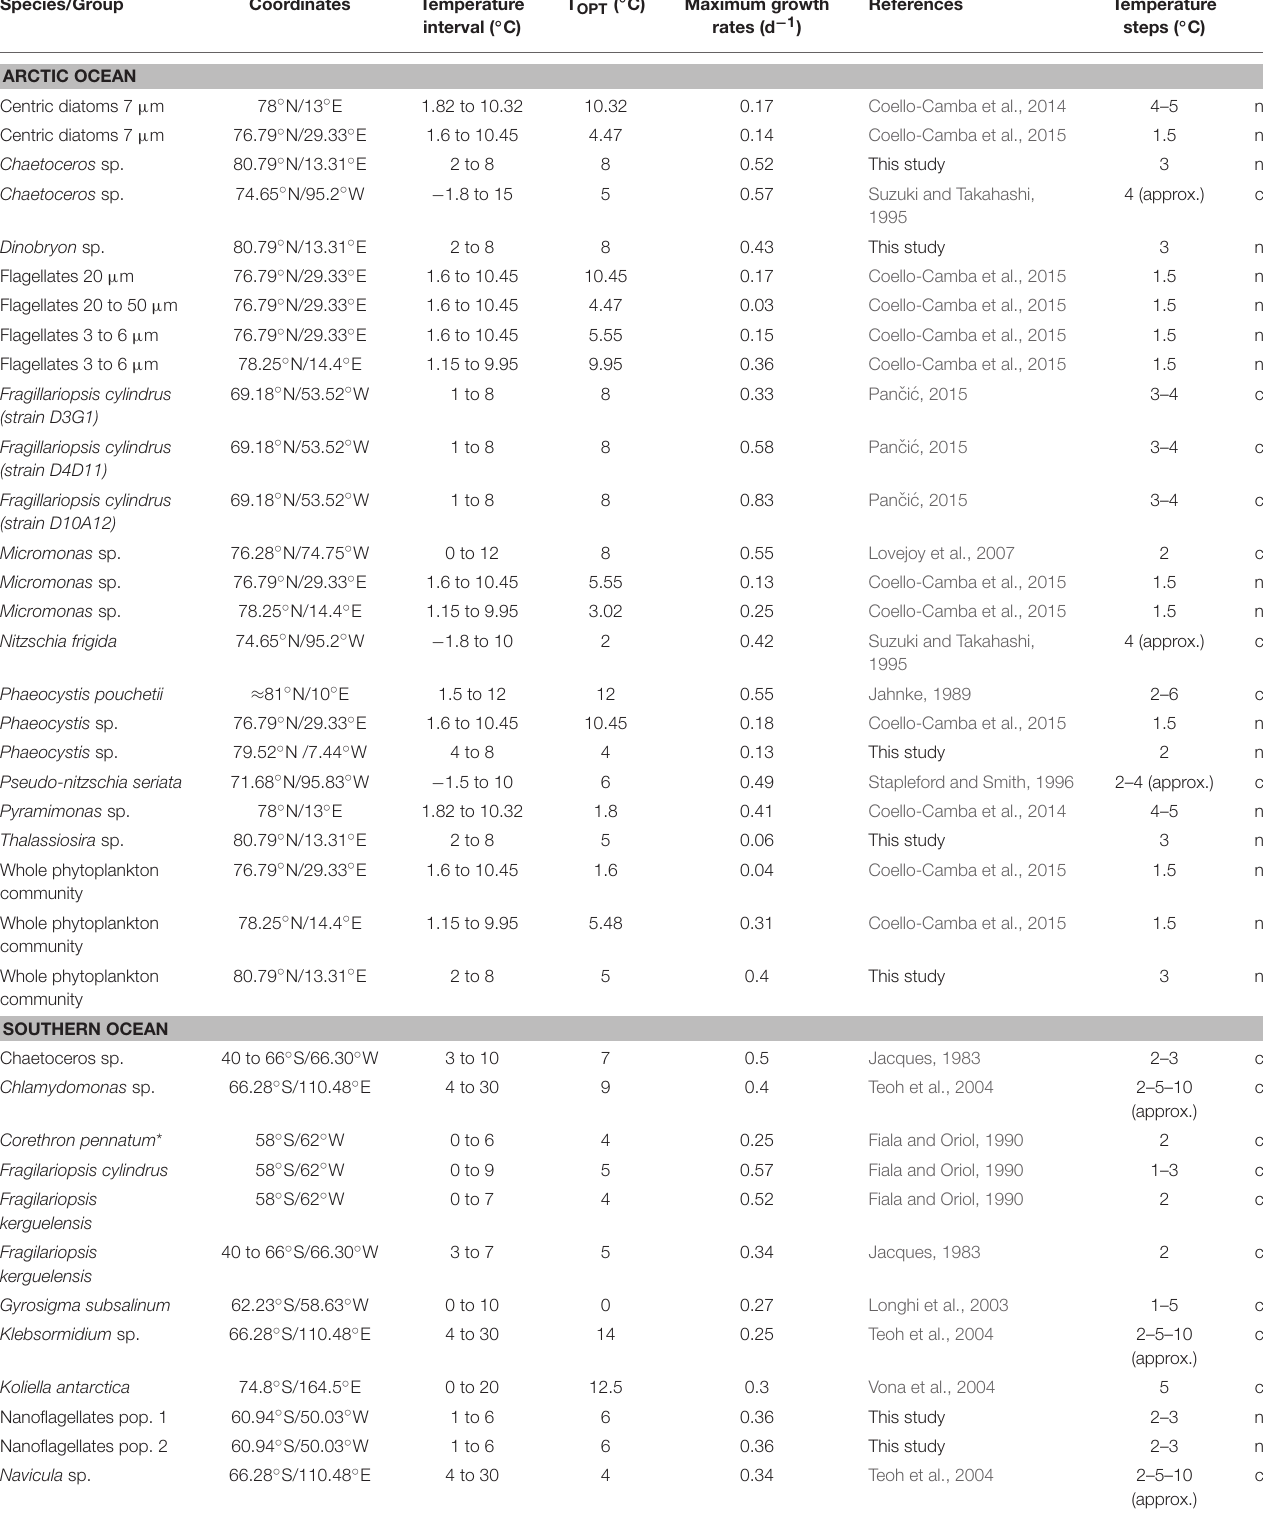
TABLE 1 | Optimum temperatures (T OPT ) and maximum growth rates ( µ max ) estimated for Arctic and Antarctic phytoplankton.